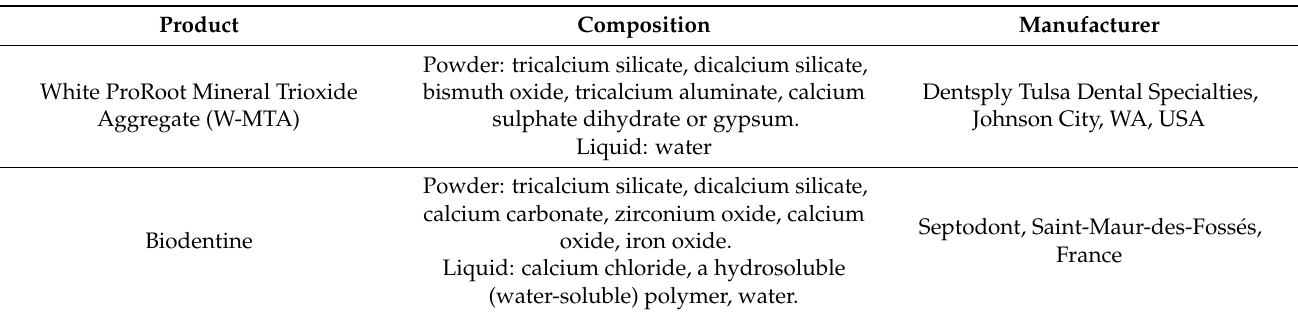
Table 3. Composition of ProRoot MTA and